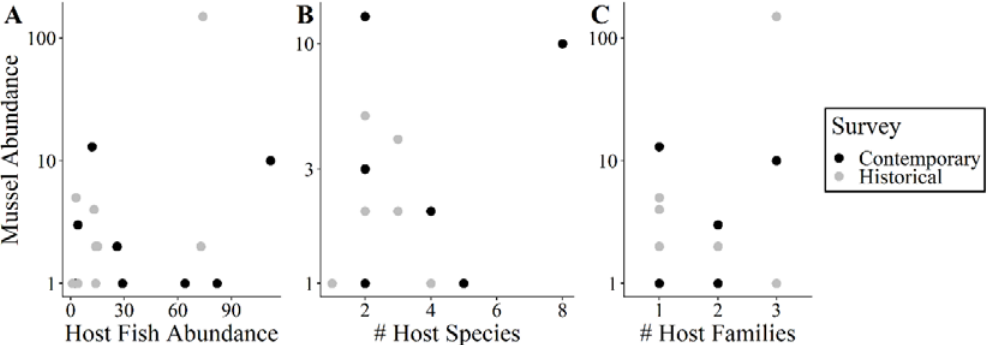
Figure 2. Host fish and mussel abundance relationships for 1986 and 1994 (historical data), respectively, and for 2017 and 2019 (contemporary data). The y axis is log 10 transformed for visualization and data analysis. ( A ) Host fish abundance and relation to mussel abundance (F 3,10 = 5.72, R 2 = 0.520, p = 0.01). ( B ) Number (#) of host fish species and mussel abundance (F 3,14 = 1.057, R 2 = 0.009, p = 0.40); abundance of Amblema plicata was removed for analysis and visualization. ( C ) Number (#) of host fish families and mussel abundance (F 3,10 = 2.02, R 2 = 0.19, p = 0.17).